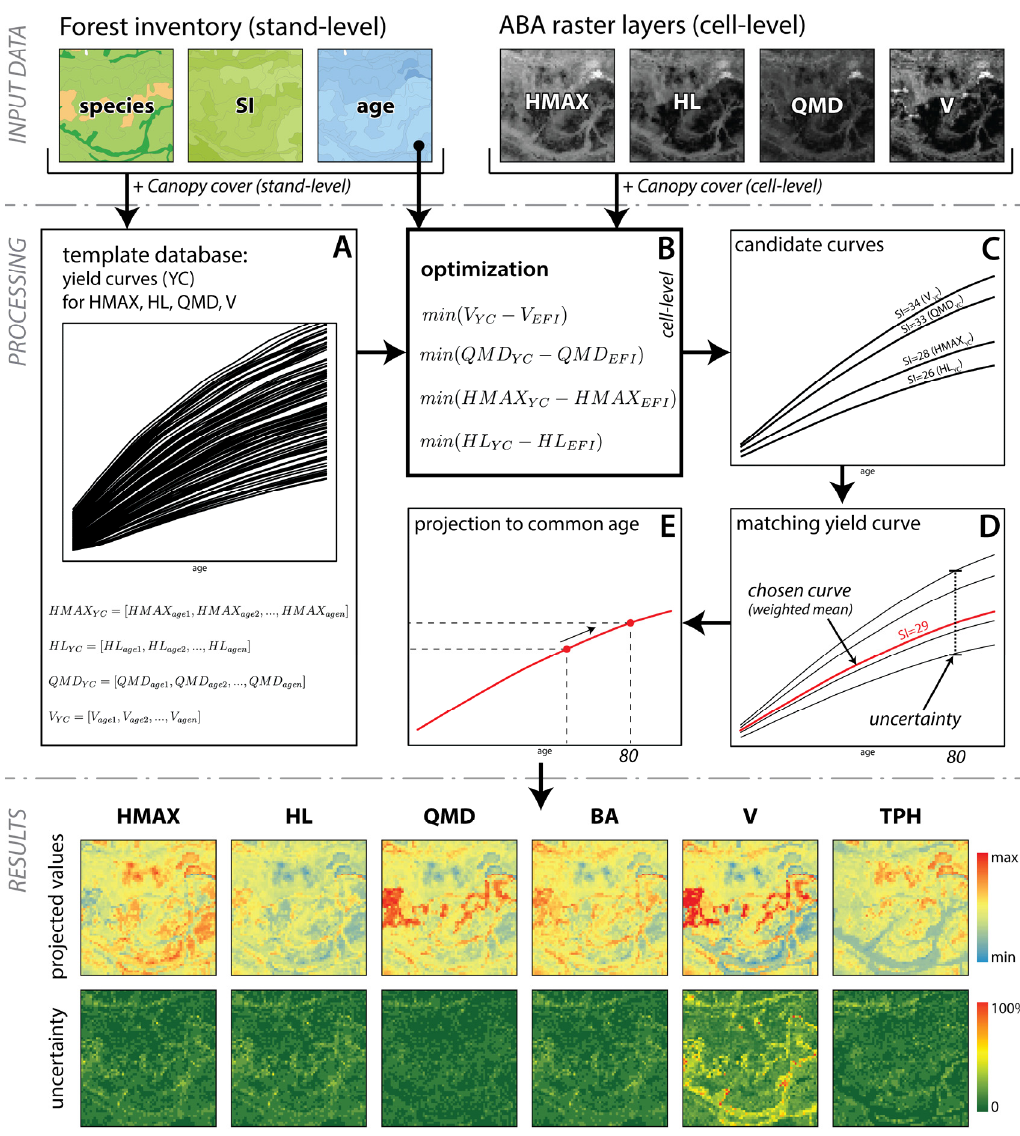
Figure 2. An outline of the processing steps. SI—site index; HMAX—dominant height, HL—Lorey’s height, QMD—quadratic mean diameter, BA—basal area, V—whole stem volume, TPH—trees per hectare. Boxes A–E are explained in detail in the text.